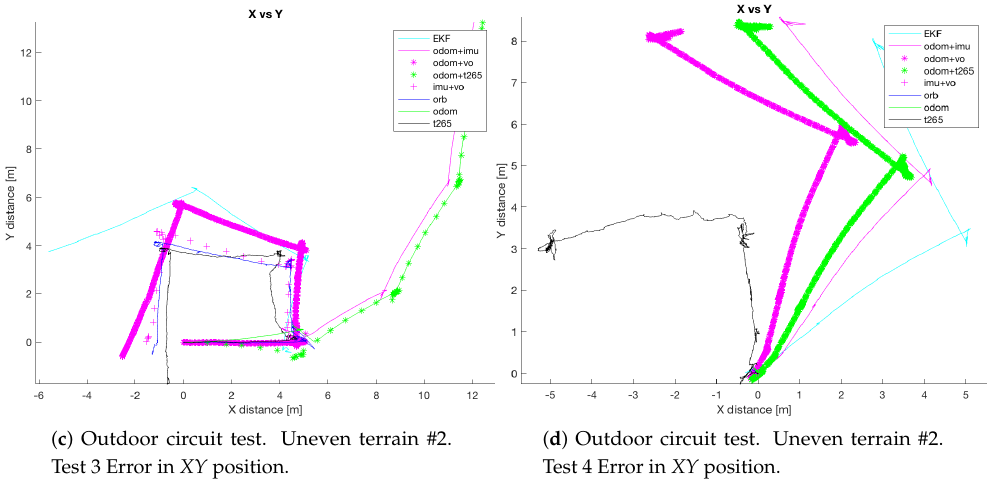
Figure 35. Outdoor circuit test on paved road.